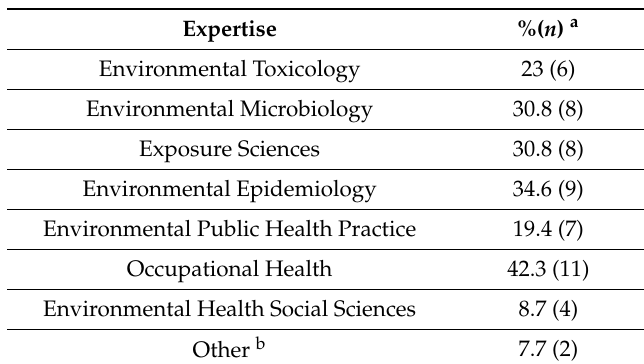
Table 1. Self-Reported Panelist